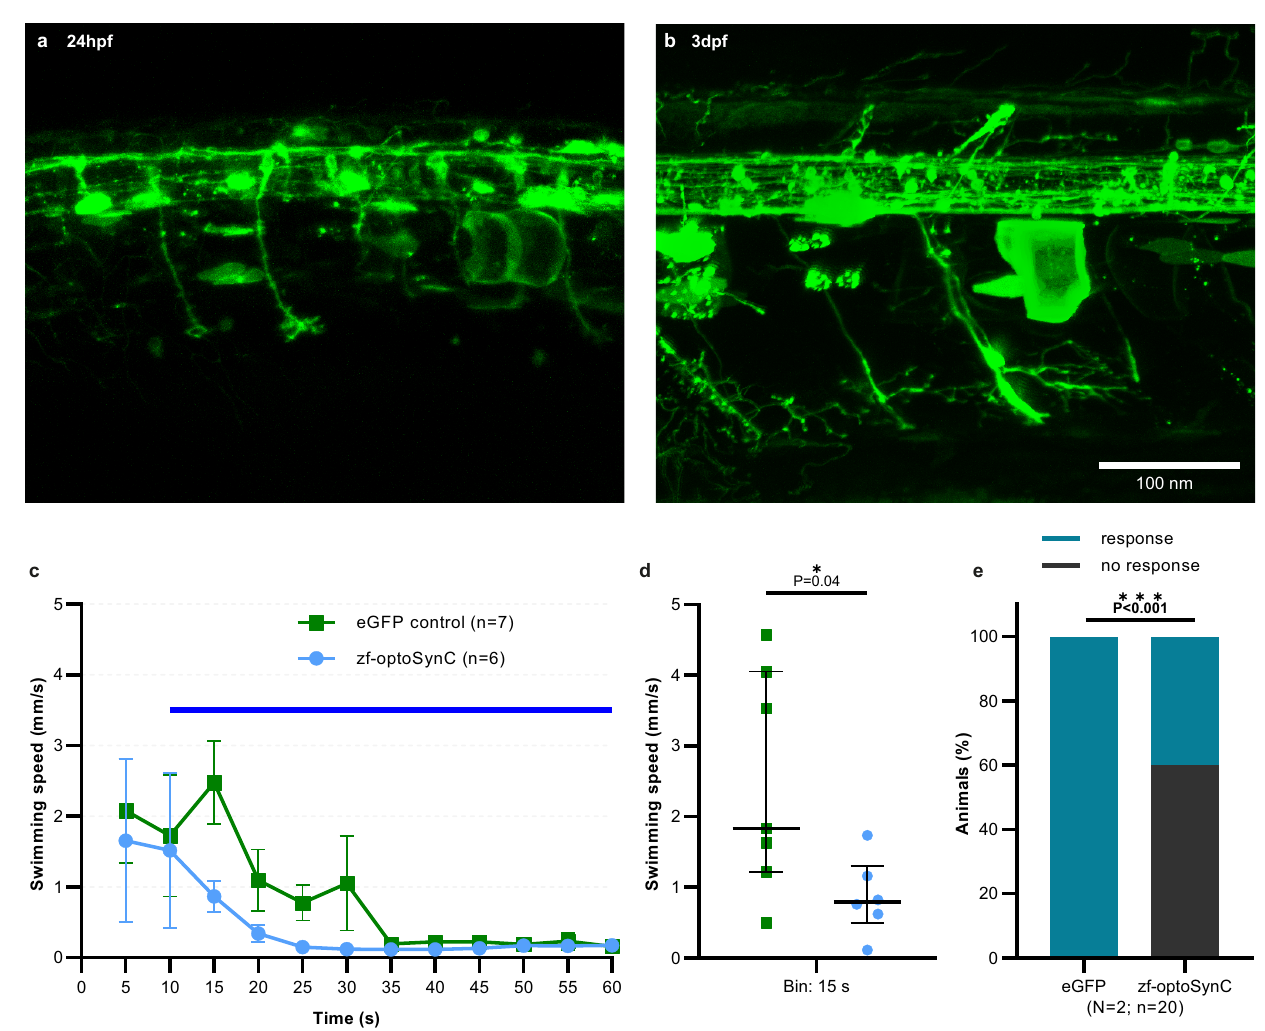
Fig. 5 | zf-optoSynC activation in zebra fi sh neurons blocks escape behavior. a , b Pan-neuronal expression of eGFP in neurons of zebra fi sh larvae at the indicated developmental stages. Representative images show transient expression in Tg(elavl3.2:Gal4-VP16)mde4 animals injected with UAS:zf-opto- SynC ( n =2 independent experiments). c Swimming behavior, triggered by continuous blue light (blue bar), in 4 dpf larvae expressing the respective